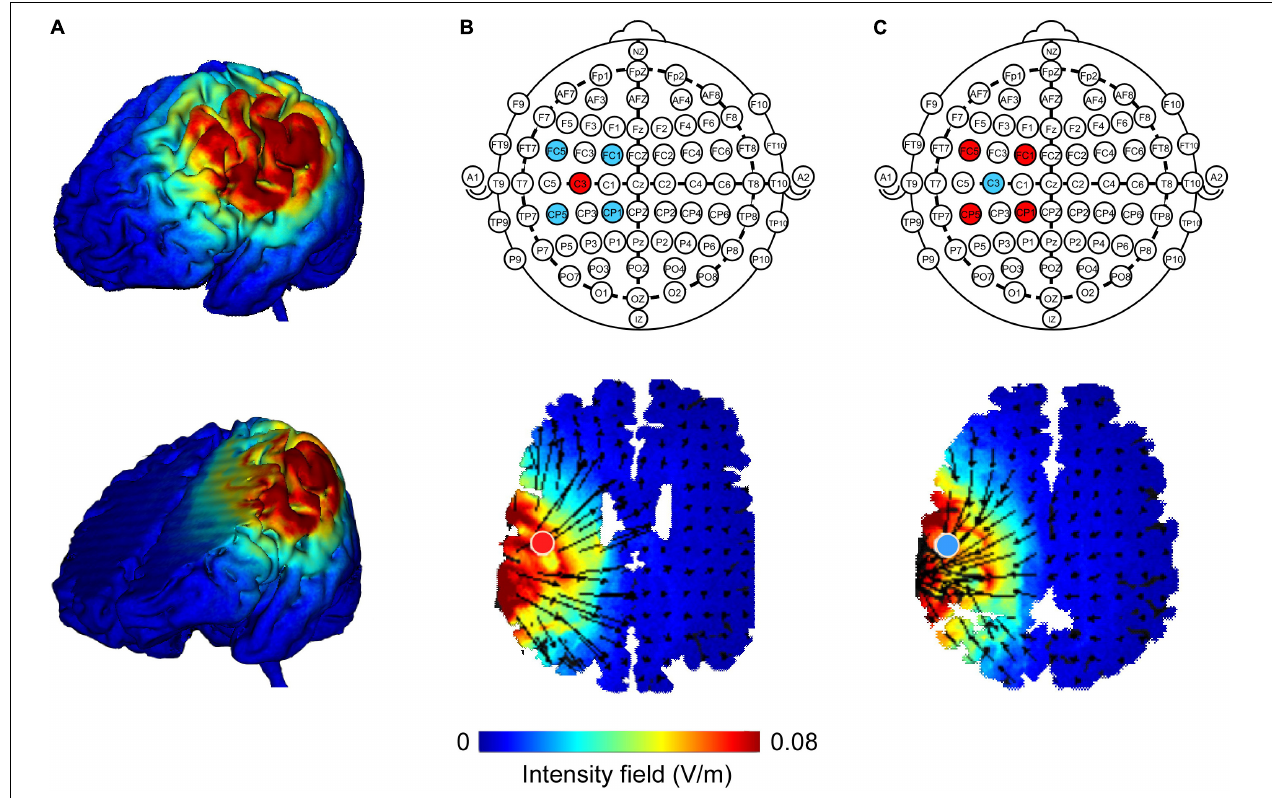
FIGURE 2 | Finite element models of high-definition transcranial direct current (HD-tDCS) of the left M1. Cortical surface and deep brain structure plots illustrate electric field magnitude ( A ; directionless; blue color represents zero electric field and the red color represents peak magnitude). HD-tDCS electrodes were placed according to the International 10–20 System. The central electrode was placed at C3 with surrounding return electrodes that are located at FC1, FC5, CP5, and CP1 (red color represents anode, blue color represents cathode). Anodal (B) and cathodal (C) modeling showed a similar current field intensity but with current flow in opposite directions. The direction of the current flow is indicated by black arrows. A field intensity range of 0.00–0.08 V/m was used.